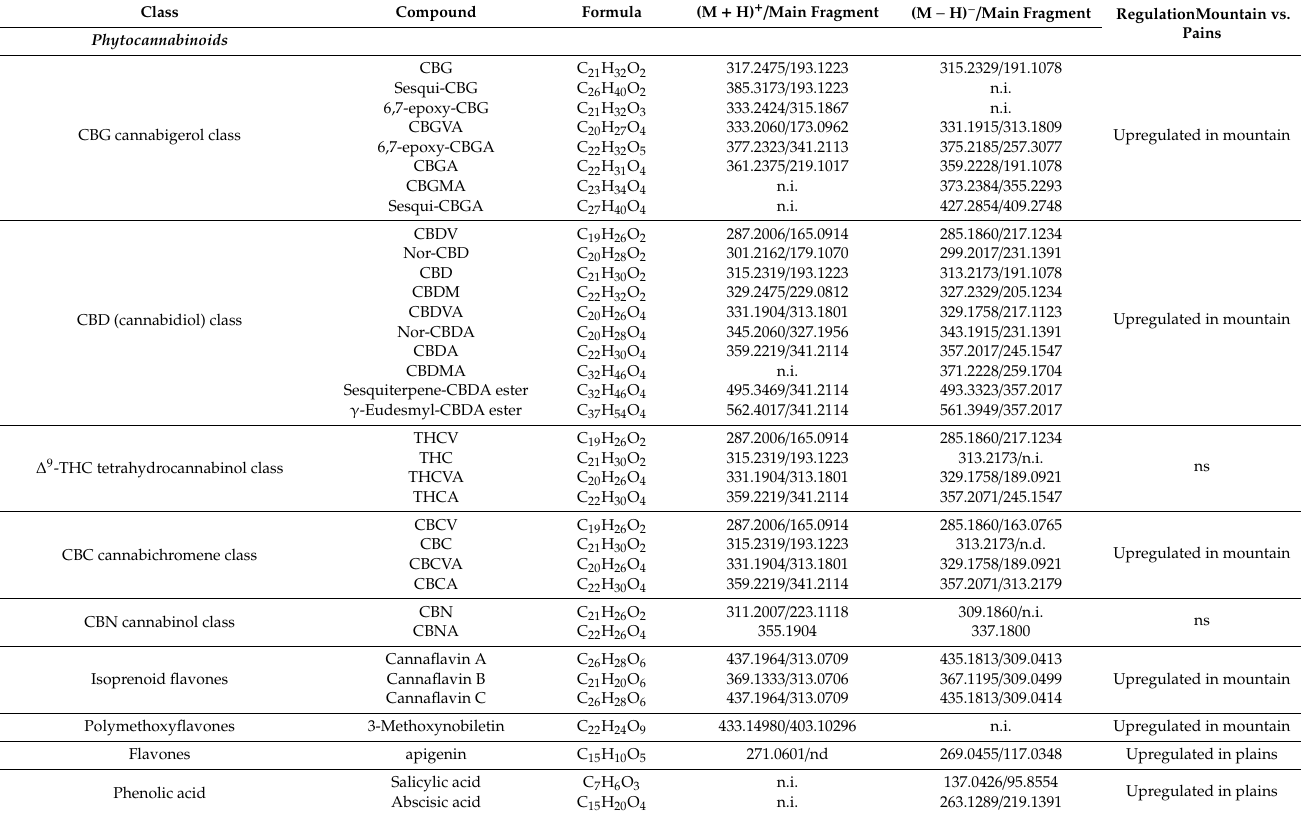
Table 3. Results regarding metabolomic identification in Kompolti